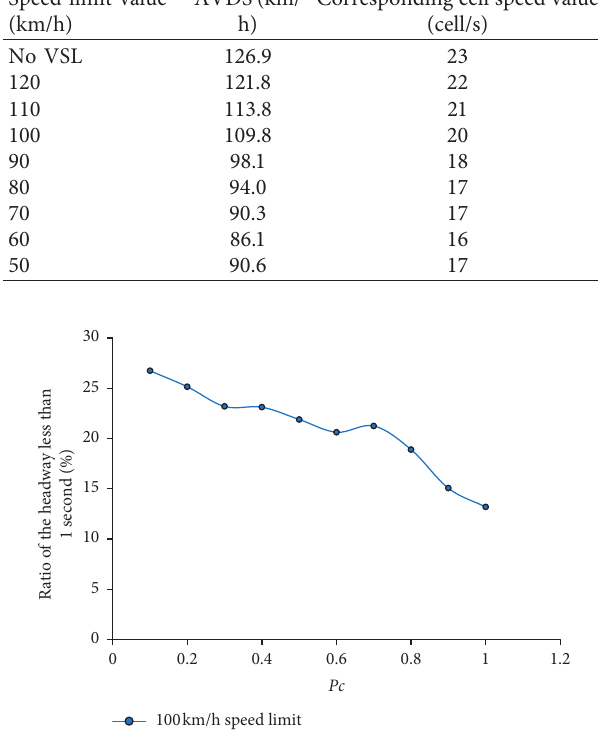
Figure 2: Proportion of the headway less than 1 second at different p c values. Table 4: Range of values of different VSL parameters, p